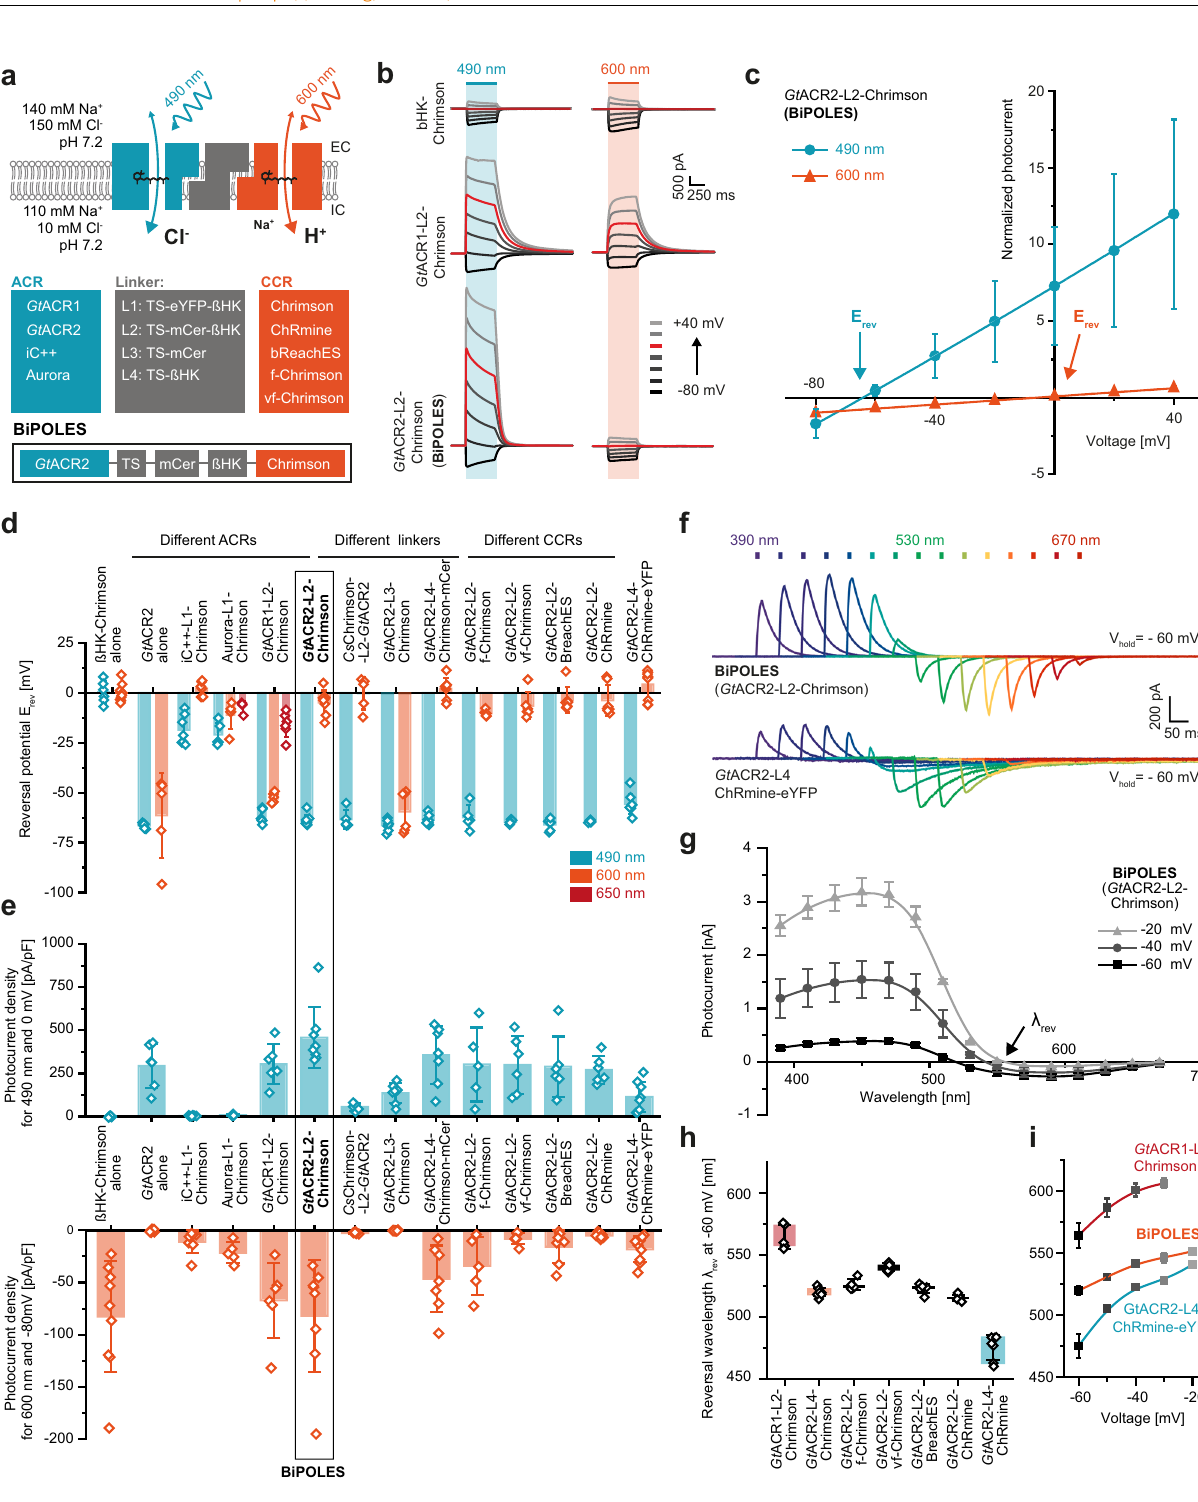
well as on the relative ionic driving forces de fi ned by the membrane voltage and the respective ion gradients (Fig. 1g – i). The red-shift of λ rev for the vf-Chrimson tandem compared to BiPOLES re fl ects the reduced conductance of this Chrimson mutant (Fig. 1h, Supplementary Fig. 1c), as already previously shown 21,24 , whereas the blue-shift of λ rev for the ChRmine tandem with L4 (Fig. 1f, h) is explained by the blue-shifted activation spectrum of ChRmine compared to Chrimson 25 and